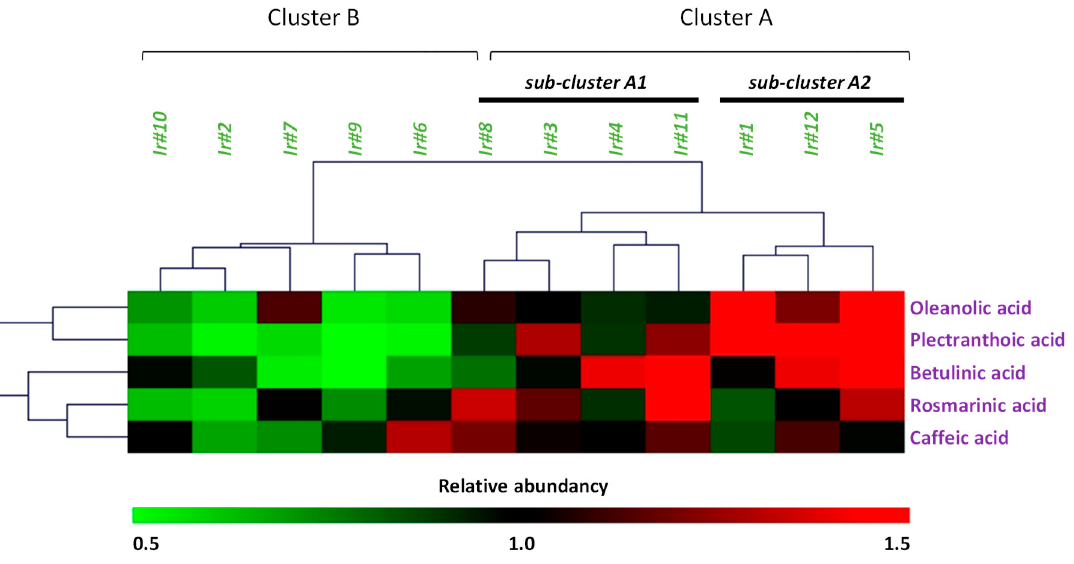
Figure 5. Hierarchical clustering analysis (HCA) of twelve I. rugosus callus extracts related to their phytochemical profile.